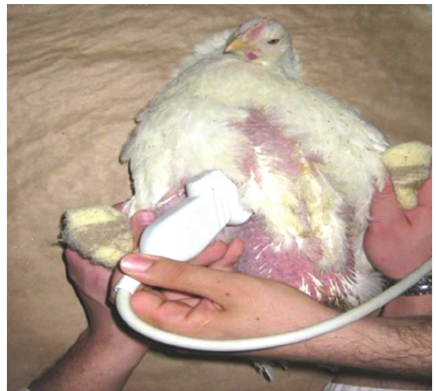
Figure 1: Position of transducer which is used for imaging echocar- diography in chicken.